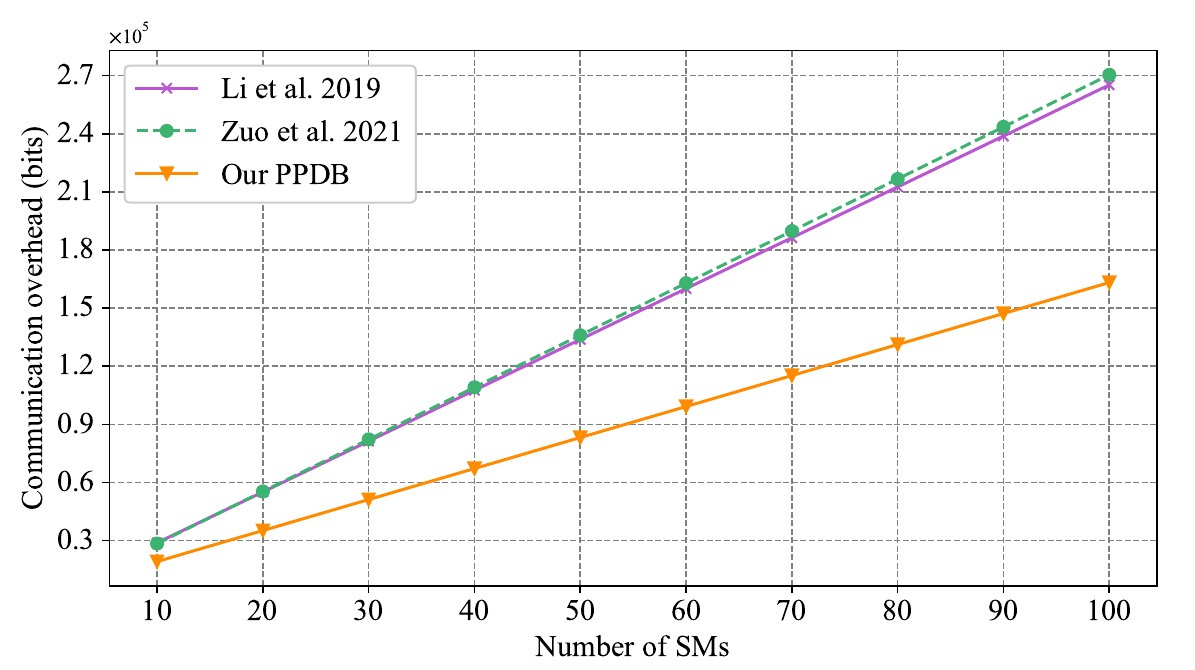
Figure 9. Comparison of communication overhead of Li et al. [23], Zuo et al. [27] and our